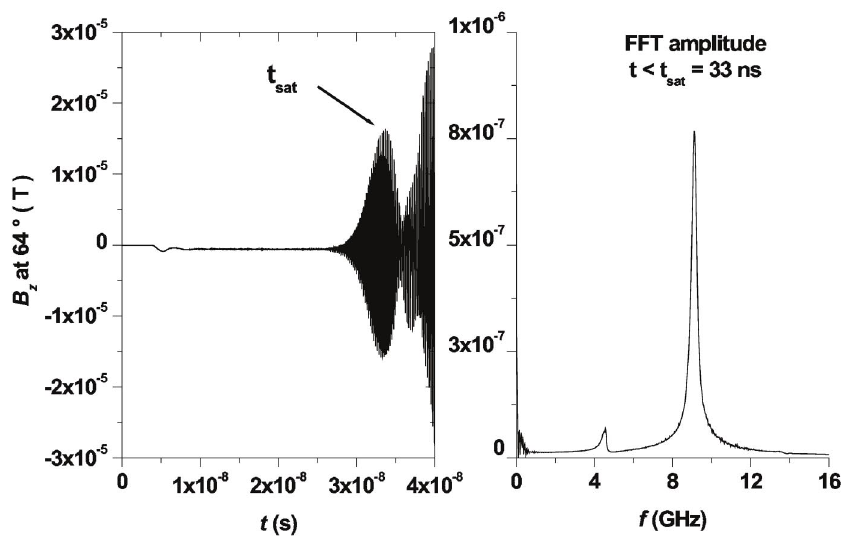
FIG. 4. Time signal of B and corresponding FFT from a detector placed at 64 (cid:5) . z